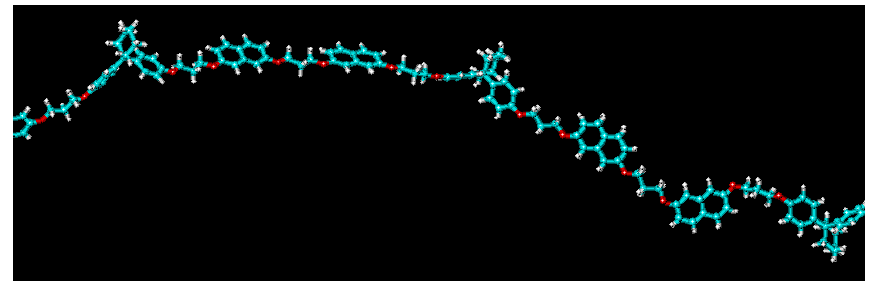
Fig. 3 Chain geometry corresponding to Sample